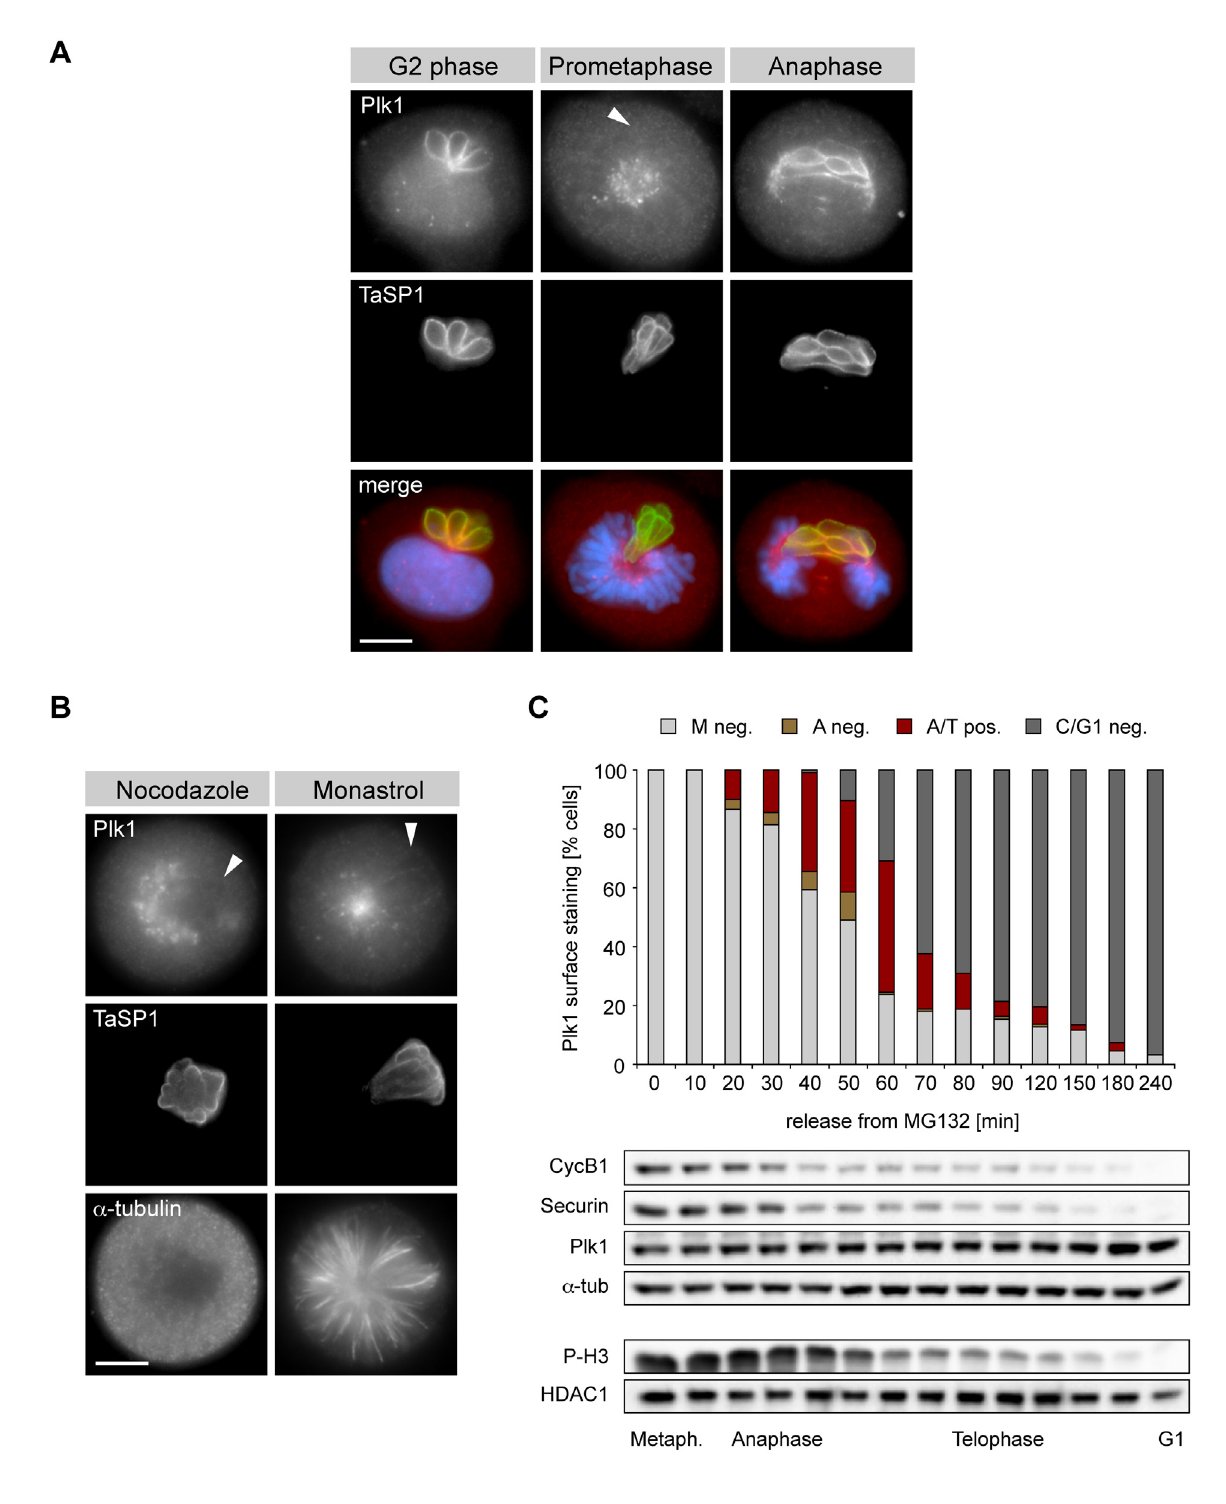
Figure 2. Biphasic recruitment of host Plk1 to the schizont surface. (A) T. annulata -transformed cells were stained with anti-Plk1, anti-TaSP1, and DAPI and analyzed by IFM. Cell cycle stages are indicated. Arrowhead indicates the position of the parasite. (B) Cells arrested in prometaphase by treatment with nocodazole (left panels) or monastrol (right panels) and analyzed by IFM using antibodies to Plk1, TaSP1 and a -tubulin. Arrowheads indicate the position of the parasite. (C) Cells were released from MG132-mediated metaphase arrest and the percentage of cells containing parasites with surface-bound Plk1 was determined by IFM ( n $ 100 cells/sample). M neg.: metaphase cells, parasite Plk1-negative; A neg.: anaphase cells, parasite Plk1-negatve; A/T pos.: Ana- & Telophase cells, parasite Plk1-positive; C/G1 neg.: cells in cytokinesis or G1, parasite Plk1-negative. Progression through M phase was monitored by immunoblot analysis using antibodies as indicated. HDAC1 (histone deacetylase 1) and a -tubulin were used as loading controls. Scale bars represent 5 m m.